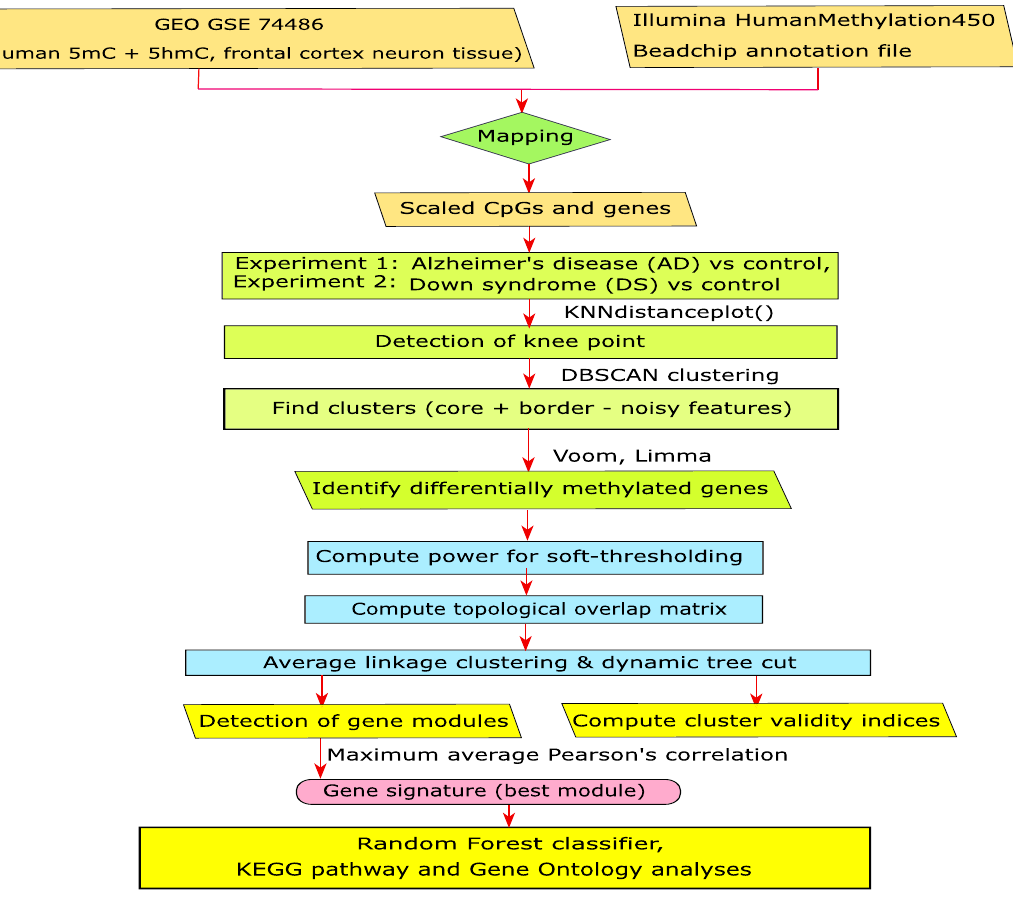
Figure 1. Flowchart of the DBSCAN framework and